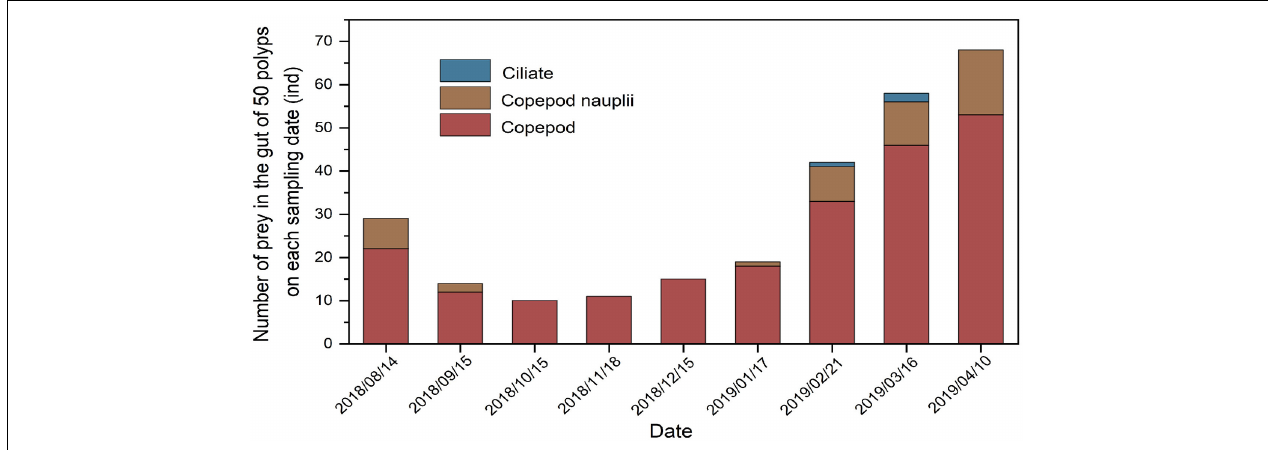
FIGURE 6 | Number of prey (copepods, copepod nauplii, and ciliates) in the gut of 50 polyps on each sampling date (50 polyps were detected on each sampling date). Sampling period ranged from August 2018 to April 2019.